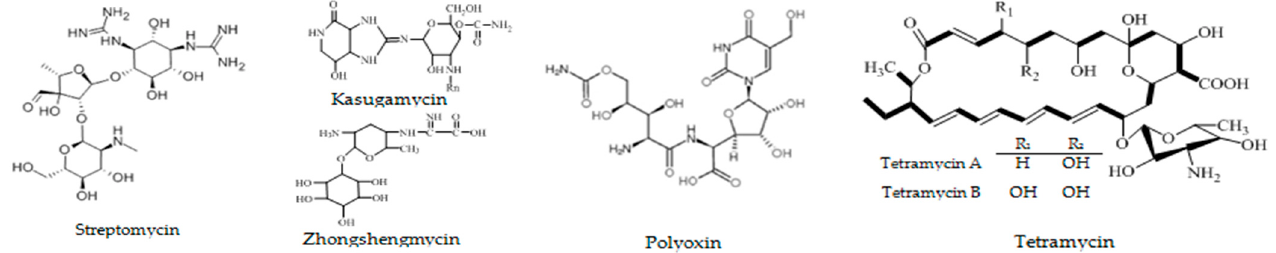
Figure 1. The chemical structures of streptomycin, kasugamycin, zhongshengmycin, polyoxin and tetramycin.